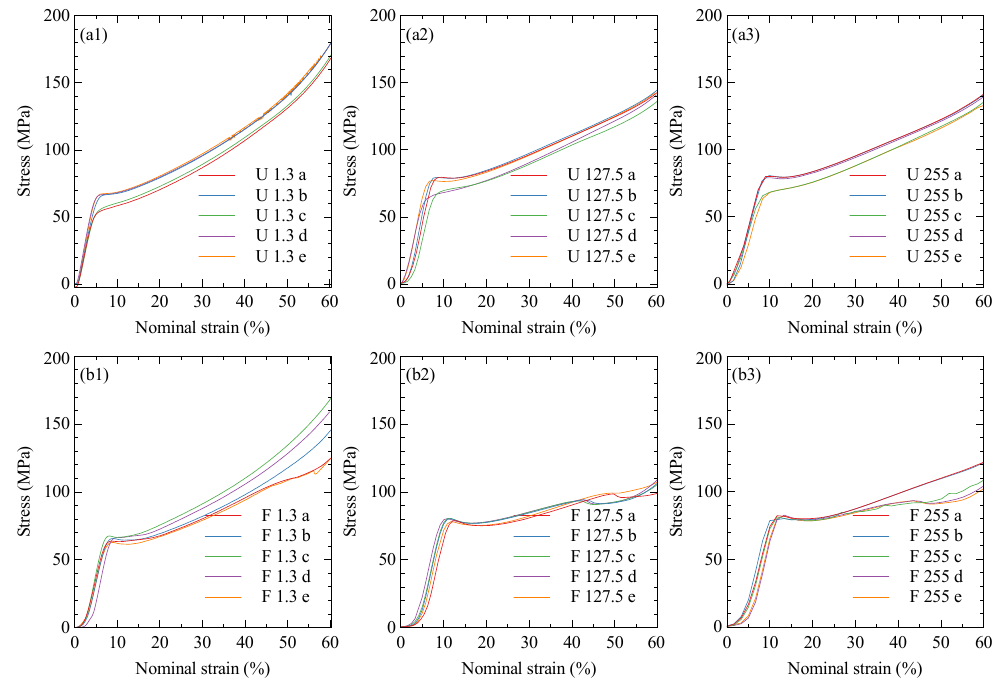
Figure 11. Nylon compressive stress–strain curves. Infill geometry denoted by ( a ) upright and ( b ) flat. Compressive speed is denoted by ( 1 ) 1.3 mm/min, ( 2 ) 127.5 mm/min, and ( 3 ) 255